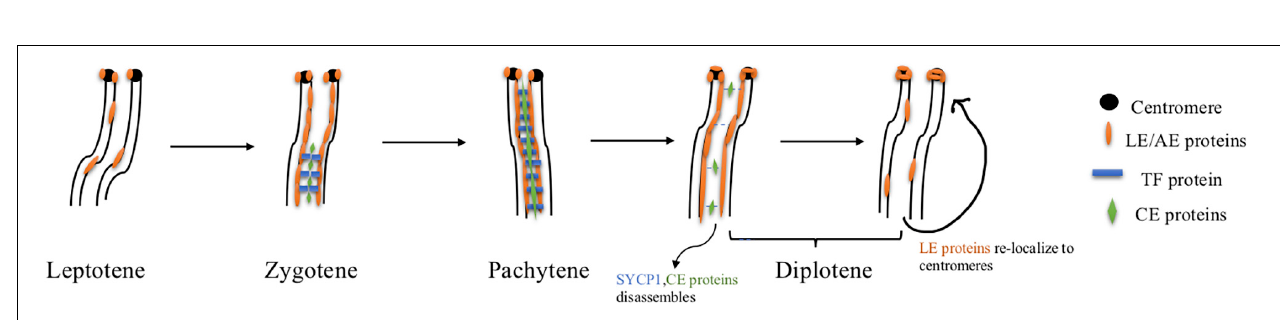
FIGURE 4 | SC assembly and disassembly in mice. Axial element proteins (orange) start to load onto chromosomes at the leptotene stage. Transverse filament protein SYCP1 (blue) as well as central element proteins (green) begin to assemble at the zygotene stage. By the pachytene stage, homologous chromosomes are fully synapsed and the axial element becomes the lateral element completing the assembly of the SC. Disassembly of the SC depends on PLK1, INCENP(AURKB), and CDK1-Cyclin B1. Phosphorylated PLK1 targets central element protein TEX12, and transverse filament protein SYCP1 to promote central region disassembly. The other central element proteins are then removed from the SC. Simultaneously, both INCENP and AURKB redistribute to centromeres and facilitate lateral element protein relocation to centromere regions. CDK1 is activated by HSPA2, and active CDK1 interacts with Cyclin B1 which also targets lateral element proteins and initiates their redistribution to